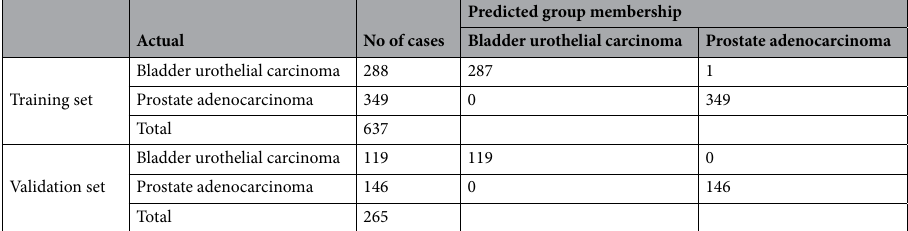
Table 8. Hit ratios for the model based on most important urothelial and prostate lineage gene expressions. 99.8% of training set cases correctly classified. 100% of validation set cases correctly classified.